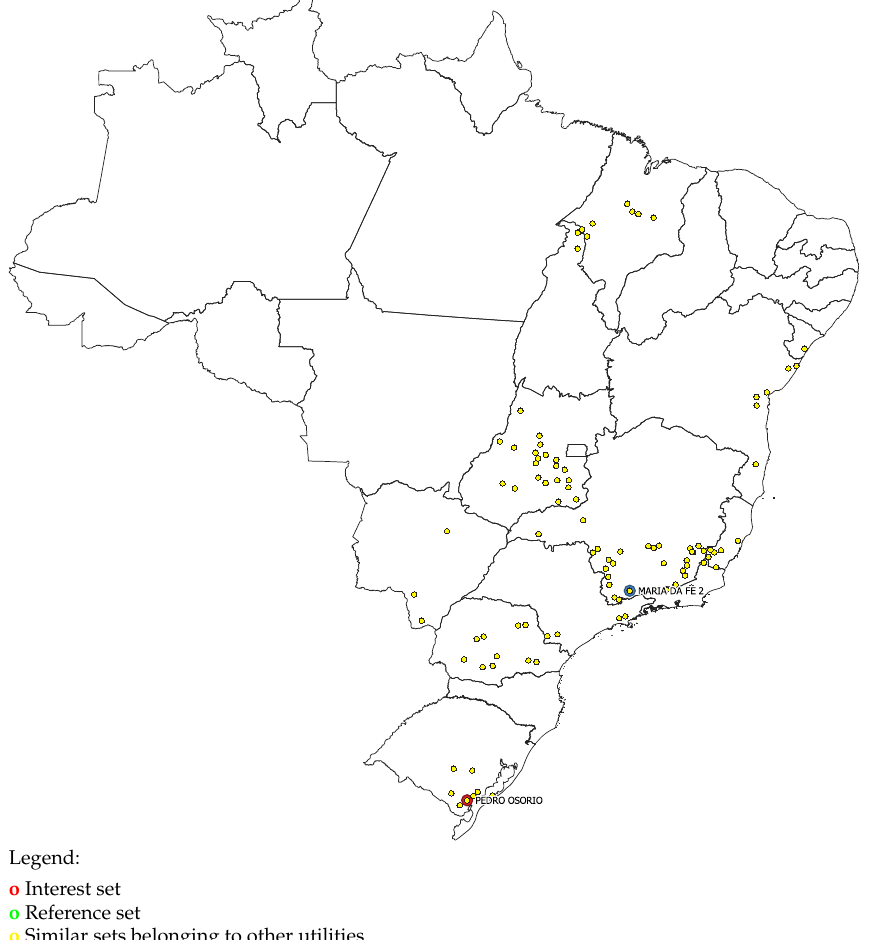
Figure 12. Geographic location of all 100 sets of cluster belonging to the Pedro Osório